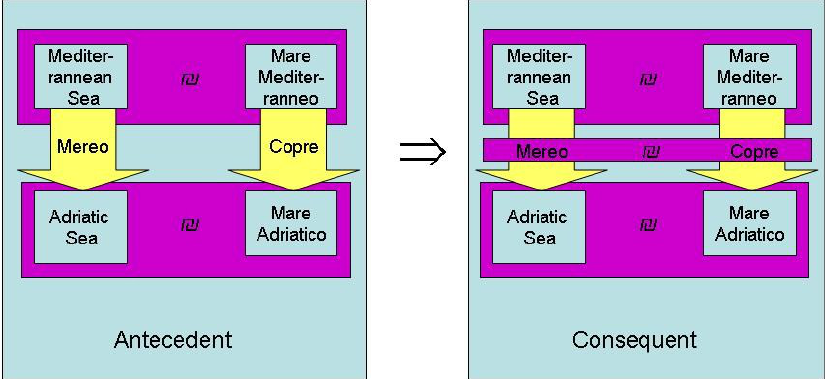
Figure 13. Example of Rule 3 for inferring homology between two relations in which “Mereo” means a meronym